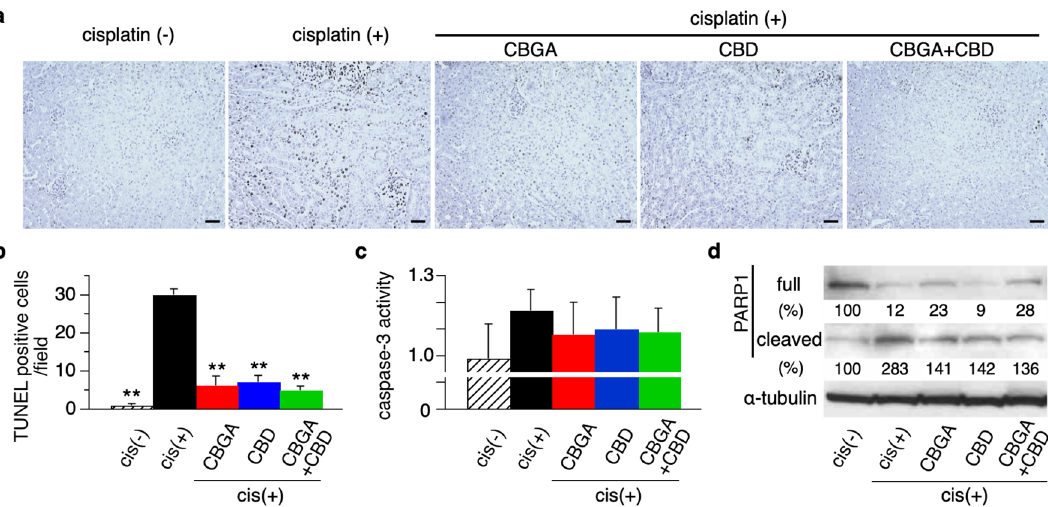
Figure 3. CBGA and CBD reduced apoptosis in cisplatin-induced acute nephropathy. ( a ) Representative pictures of TUNEL-positive apoptotic cells in kidneys from non-cisplatin administered mice or cisplatin- induced nephropathy mice treated with CBGA, CBD or CBGA + CBD (magnification × 200). Scale bars represent 50 µm. (The pictures of high magnification are shown in Supplementary Fig. S1). ( b ) Quantitative analysis of TUNEL-positive renal tubular epithelial cells assessed in kidneys from cisplatin (+) group (black bar), CBGA treatment group (red bar), CBD treatment group (blue bar), CBGA + CBD treatment group (green bar) at day 3. Shaded bar represents the non-cisplatin treatment group as control. ( c ) Caspase-3 activity in kidneys was determined using Caspase-3 assay kit (see “Materials and methods”). ( d ) The levels of full-length PARP1 and cleaved PARP1 protein expression were assessed in kidney tissue from cisplatin-induced acute nephropathy using western blotting (full image is shown in Supplementary Fig. S2). The quantitative percentages are indicated under each picture. **p < 0.01 vs. cisplatin (+) treatment